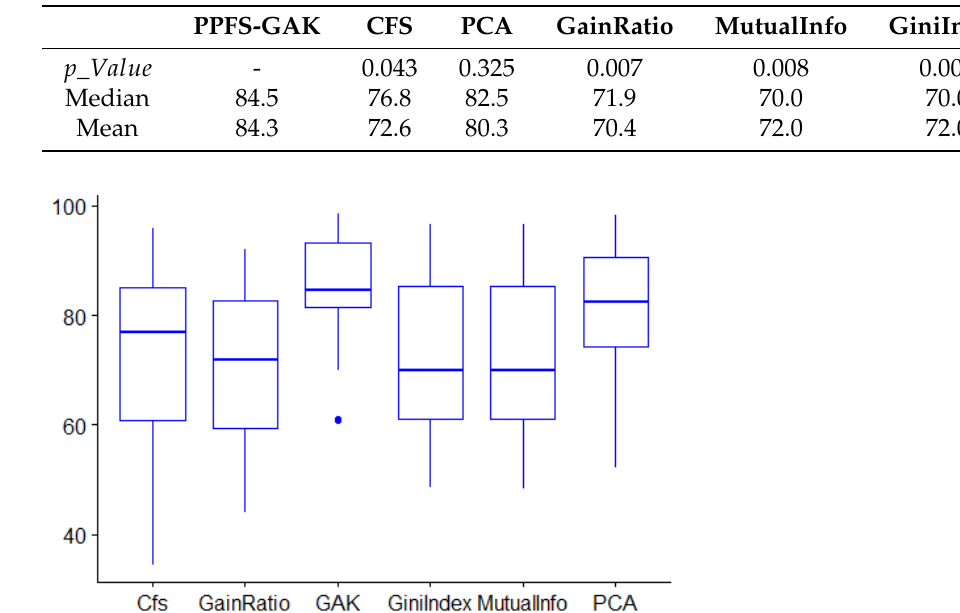
Figure 8. Boxplot of the accuracy obtained by SVM after applying GAK and the 5-filter FS for all the datasets. The y-axis represents the minimum, first quartile, median, third quartile, and maximum value of the accuracy